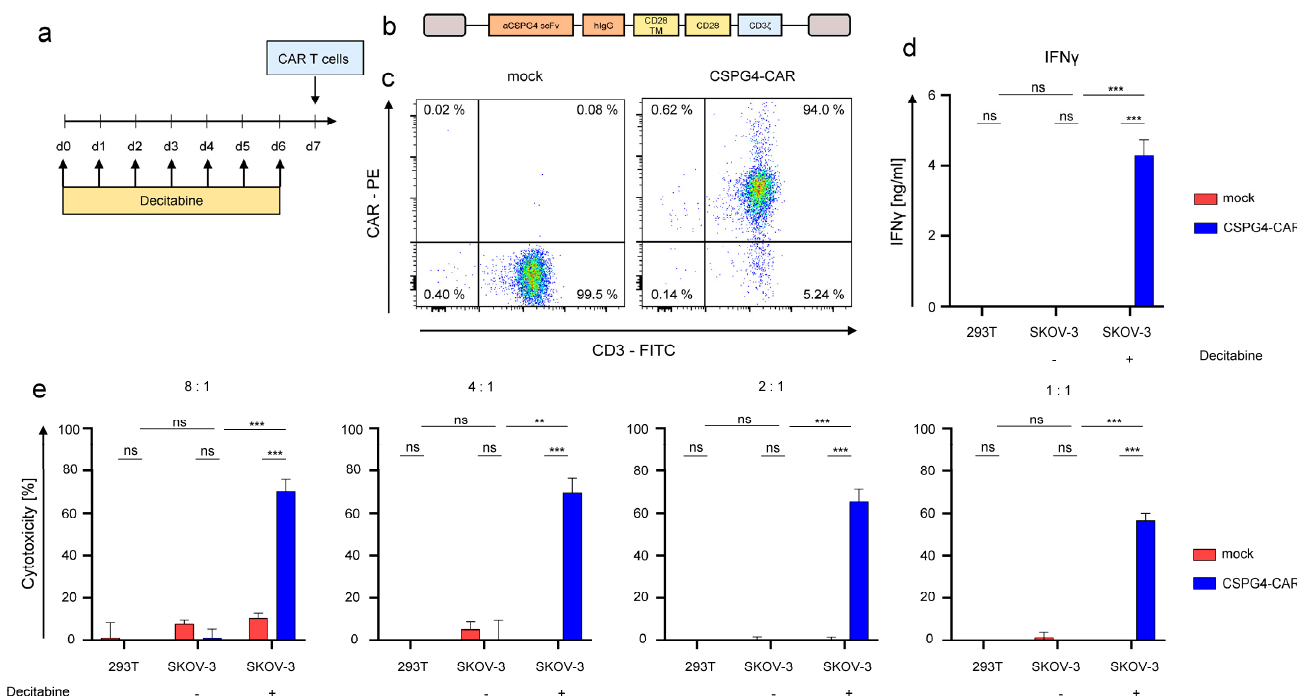
Figure 4. Decitabine-mediated upregulation in SKOV-3 ovarian cancer cells enables antigen-specific targeting via CSPG4-CAR-T cells. ( a ) Schematic showing the experimental layout for the experiments involving CSPG4-CAR-T cells. CSPG4-CAR-T cells were generated via RNA electroporation after 10 days of OKT3/IL-2 driven expansion. SKOV-3 cells were treated daily either with 1 µM of decitabine or PBS for 6 days prior before co-culture with CAR-T cells. ( b ) Construction plan for the second-generation CD28-co-stimulated CSPG4-specific CAR. ( c ) Expression of the CSPG4-CAR was confirmed 24 h after electroporation using a Phycoerythrin (PE)-labeled goat anti-human IgG antibody. Mock (electroporation without RNA)-T cells were used as controls. One representative donor out of three independent experiments is shown. ( d ) Interferon gamma secretion by CSPG4-CAR-T cells and mock-T cells in response to 293T cells (CSPG4-negative), SKOV-3 cells either treated with decitabine or with PBS T cells were co-cultured with target cells 24 h after electroporation at a 4:1 ratio for 48 h before supernatants were recovered and IFN γ was quantified via ELISA. Data represent means ± SEM of three donors, p values were calculated by Student’s t -test, *** indicates p ≤ 0.001, and ns indicates not significant. ( e ) Cytotoxicity of CSPG4-CAR-T cells and mock-T cells upon a 48 h co-culture with 293T cells, and SKOV-3 cells either treated with PBS or decitabine was assessed at the indicated effector to target ratios via an XTT-based colorimetric assay. Data represent means ± SEM of three donors, p values were calculated by Student’s t -test, *** indicates p ≤ 0.001, ** indicates p ≤ 0.01, and ns indicates not significant.